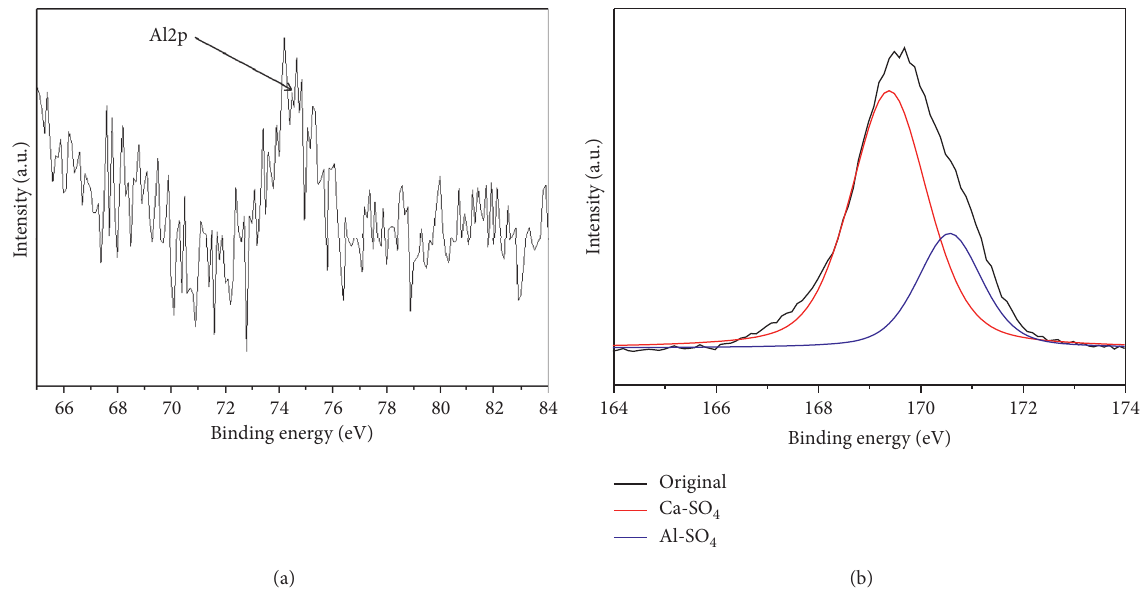
Figure 8: XPS pattern at a reaction time of 1h when the aluminum ion concentration was 5mM.